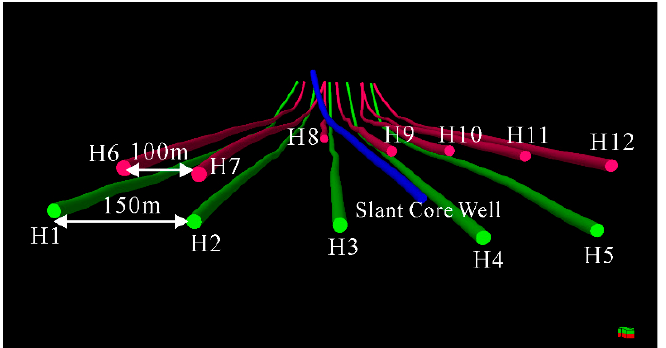
Figure 1. Three-dimensional view of CHFTS wells. Wells in red are T 1 b 3 and those in green are T 1 b 2 . The slant core well is in blue, and it passes through the fracture networks of wells H8/H9 in the T 1 b 3 formation and well H4 in the T 1 b 2 formation.